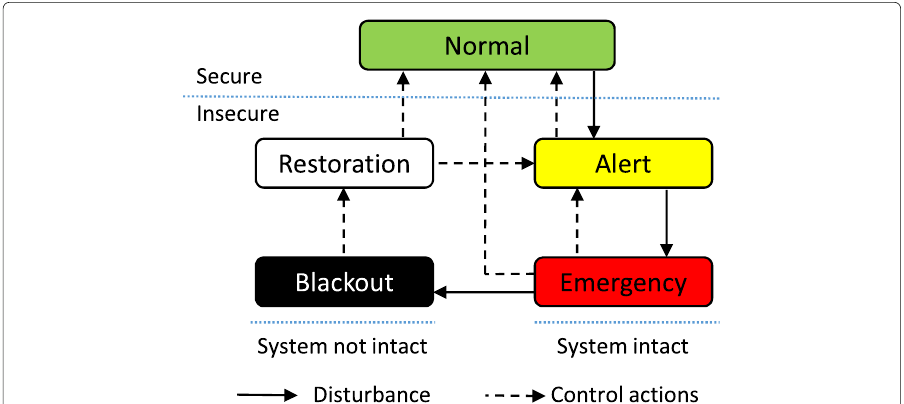
Fig. 1 ENTSO-E Power systems State Classification (Fink and Carlsen